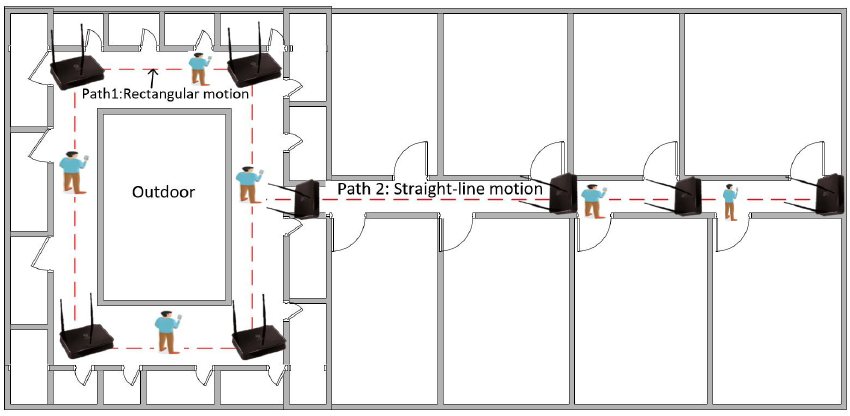
Figure 6. Experiment